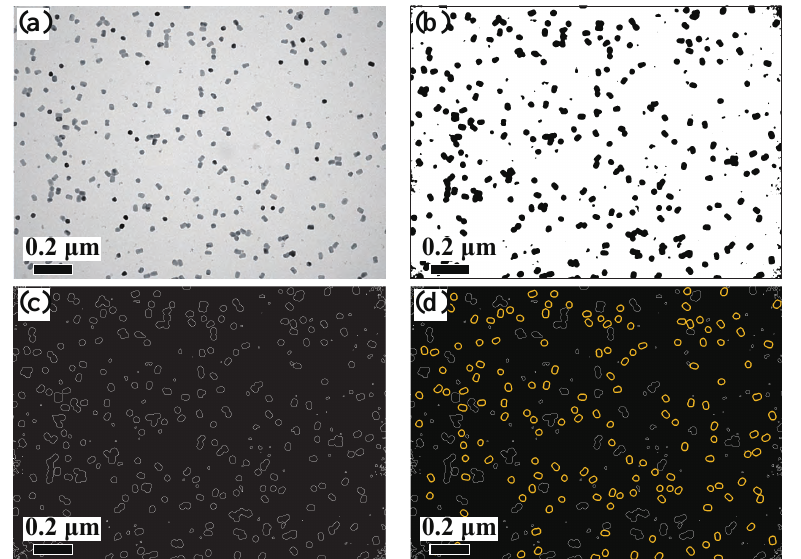
Figure 3. Image pre-processing of the UCNPs TEM image. ( a ) A low-mag, BF-TEM image for well dispersed UCNPs sample. ( b ) Binary image after the dynamic background processing. ( c ) Particle edges detected by the Canny Edge detection method. ( d ) Convexity filtered particle contours (yellow), where all the non-convex particle aggregates (grey) are filtered